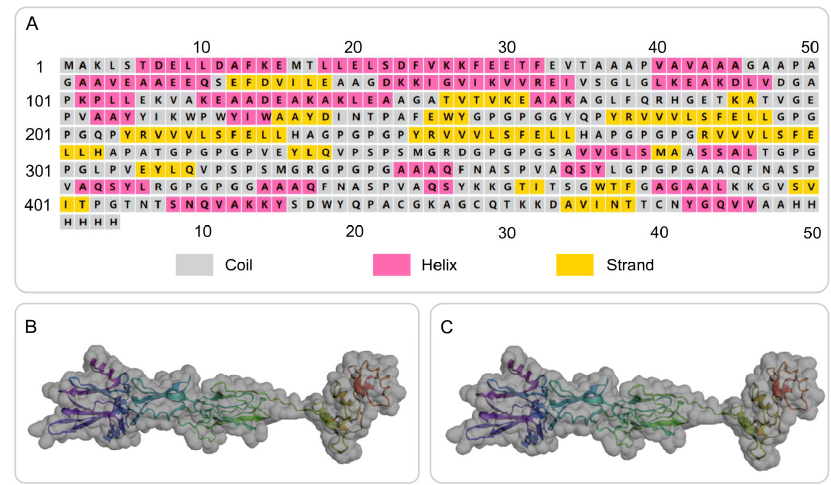
Figure 2. Secondary and tertiary structure prediction of the S7D5L4 vaccine. ( A ) I-TASSER predicted 3D models of vaccine candidates. ( B ) Optimized 3D model using I-TASSER. ( C ) The selected vaccine contained 31.72% α -helixes, 20.70% β -strands, and 47.58% random coils. The amino acid sequence of the S7D5L4 vaccine was indicated in purple to red from the N-terminal to the C-terminal.